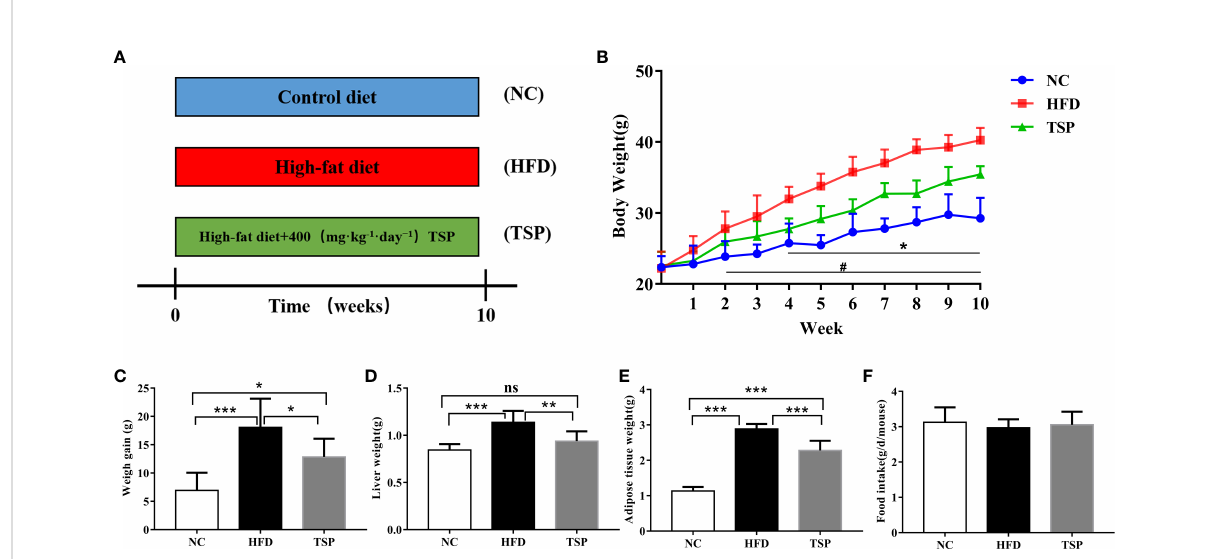
FIGURE 1 Effects of TSP consumption on the (A) the experimental protocol used in this study, n=8, (B) body weight # p < 0.05, NC compare with HFD, * p < 0.05, TSP compare with HFD, (C) body weight gain, (D) liver weight (E) adipose tissue weight, (F) food intake. Data are expressed as means ± SD ( n = 8). #/ * p < 0.05, ** p < 0.01, and *** p < 0.001, ns, no signi fi cant p >